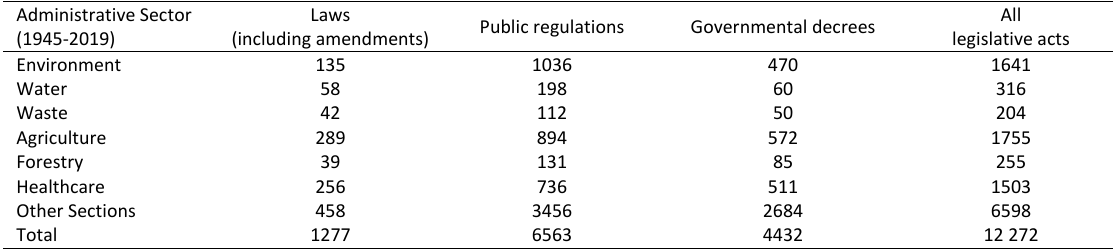
Table 1: Legislative Acts Classification Based on Administrative Sector